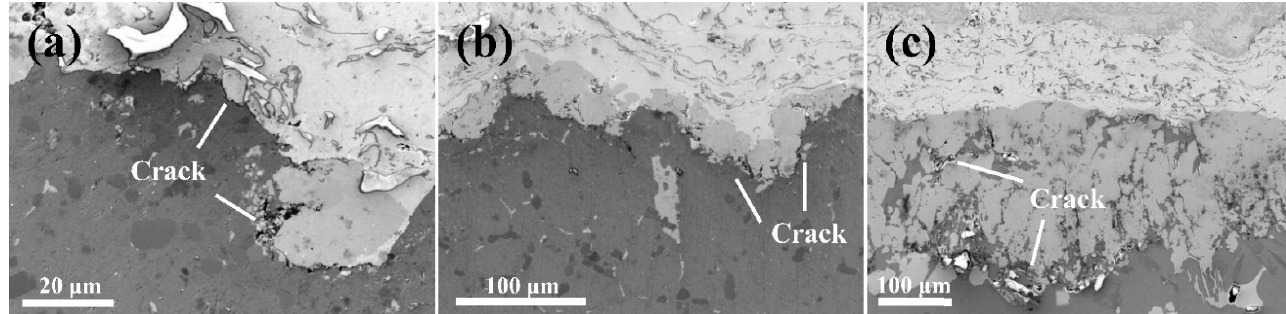
Figure 4. SEM micrographs of the Al/Fe alloys hybrid structure’s interface under excessive heat treatment for 8h; ( a ) 500 °C, ( b ) 530 °C, and ( c ) 550 °C. Table 4. The qualitative analysis of the intermetallic phase corresponding to the points in Figure